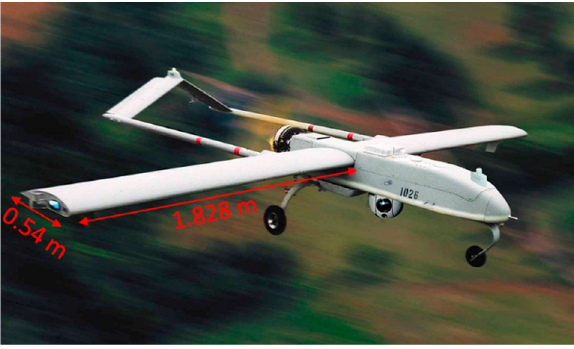
Figure 2. Selected UAV model RQ-7 shadow [38].